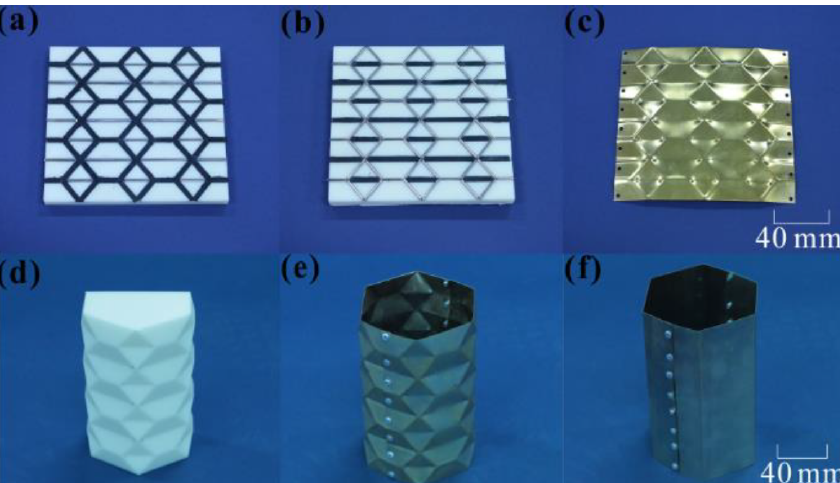
Figure 2. Fabrication of origami crash box samples: (a) male mold; (b) female mold; (c) a patterned sheet after stamping; (d) a half-tube mold by 3-D printing; (e) a completed origami crash tube; (f) a conventional hexagonal tube.